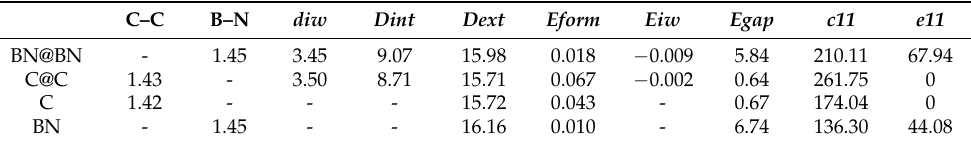
Table 1. Structural properties (in Å) and energetics (in eV) at the PBE0 level of the reference systems: double-wall (11,0)@(20,0) zigzag carbon and BN nanotubes and (20,0) single-wall nanotubes. Bond length (C–C, B–N, C–B, and C–N), inter-wall distance ( diw ), internal and external diameters ( Dint and Dext ), formation and inter-wall energies ( Eform , Eiw ), band gap energy ( Egap ), elastic ( c11 , Hartree), and piezoelectric constants (| e11 |, |e|*Bohr).